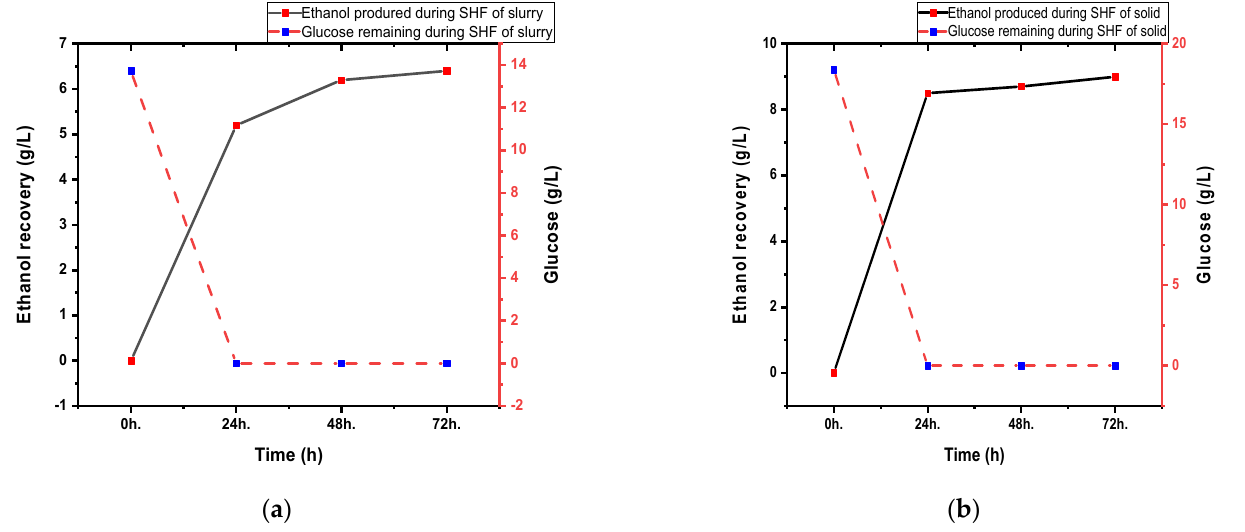
Figure 2. Ethanol production and sugar consumption profile during separate hydrolysis and fer- mentation at 30 °C of ( a ) whole slurry, and ( b ) solid fraction of hydrothermally pretreated pineapple leaves at 150 °C for 20 min. Ethanol production and glucose consumption are estimated by HPLC.